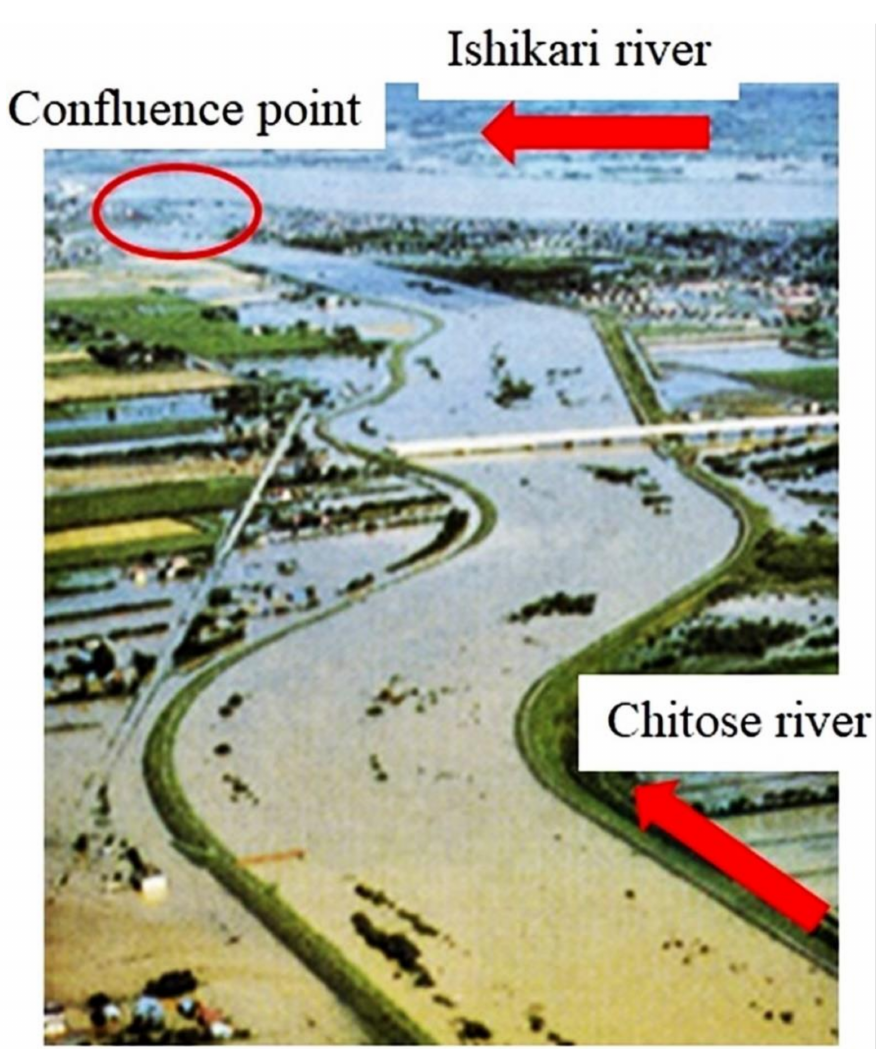
Figure 2. Severe flood inundation event in August 1981 in the Chitose River basin (CRB). Data source: Hokkaido Regional Development